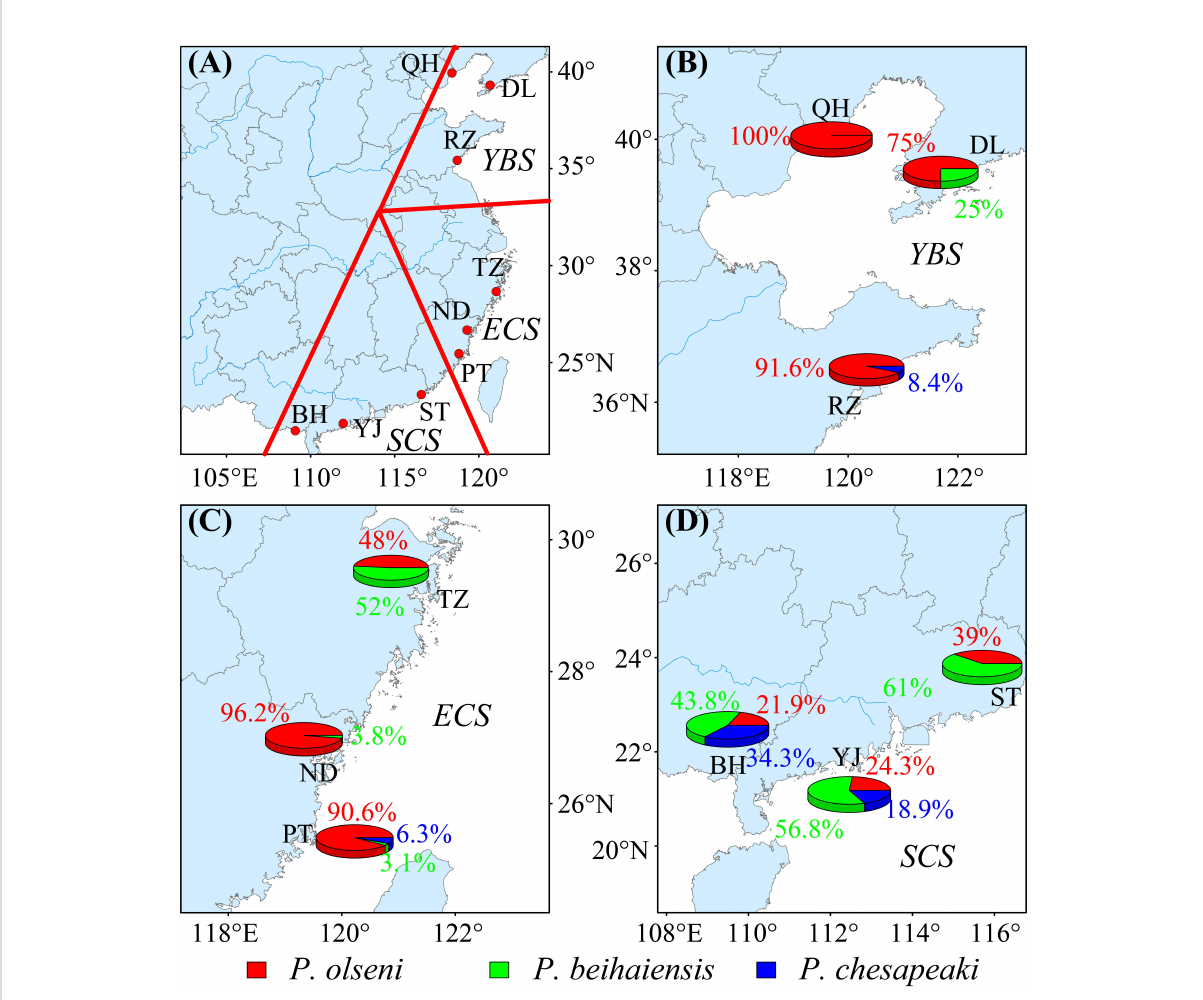
FIGURE 1 Map of sampling locations along the coast of China (A) and Perkinsus species carrying rate in molluscan species at different locations in the Yellow and Bohai Sea (YBS) (B) , East China Sea (ECS) (C) , and South China Sea (SCS) (D) . DL, Dalian; QH, Qinghuangdao; RZ, Rizhao; TZ, Taizhou; ND, Ningde; PT, Putian; ST, Shantou; YJ, Yangjang; BH,